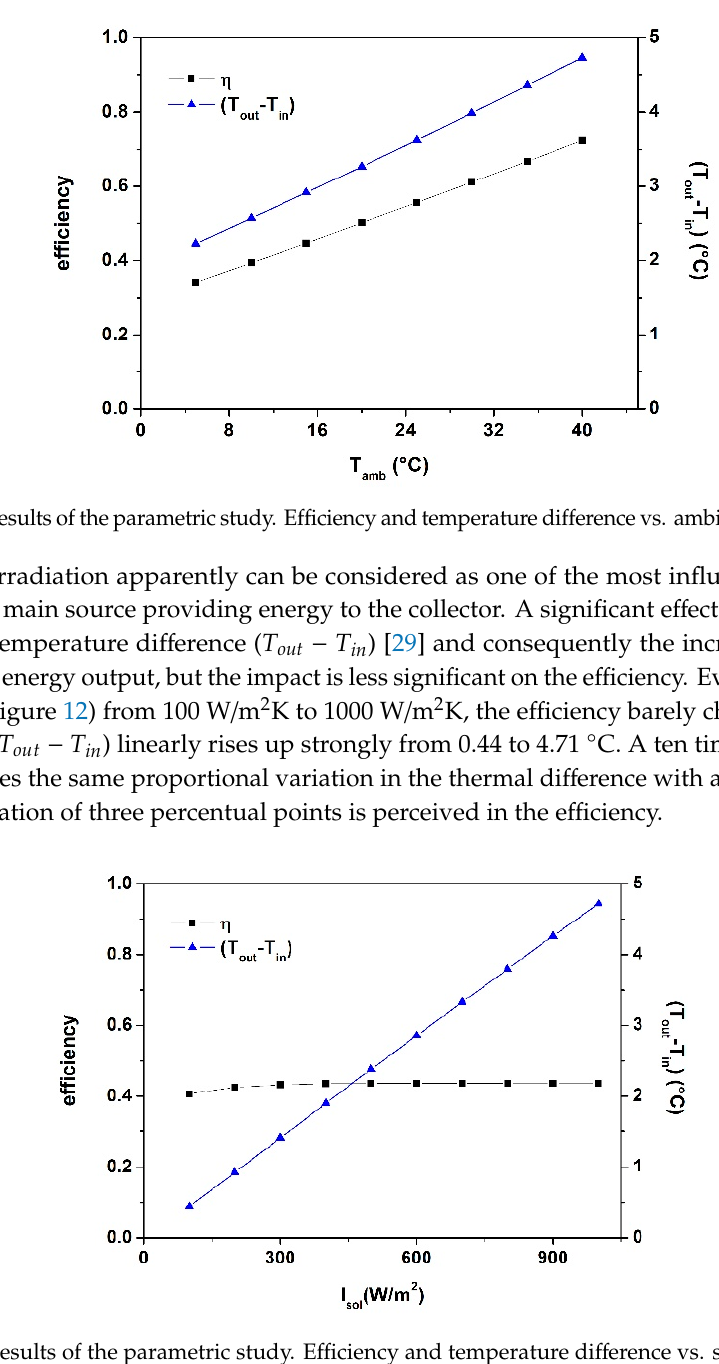
12 of 21 Figure 10. Results of the parametric study. Efficiency and temperature difference vs. mass flow rate. 3.1.2. Dynamic Meteorological Parameters